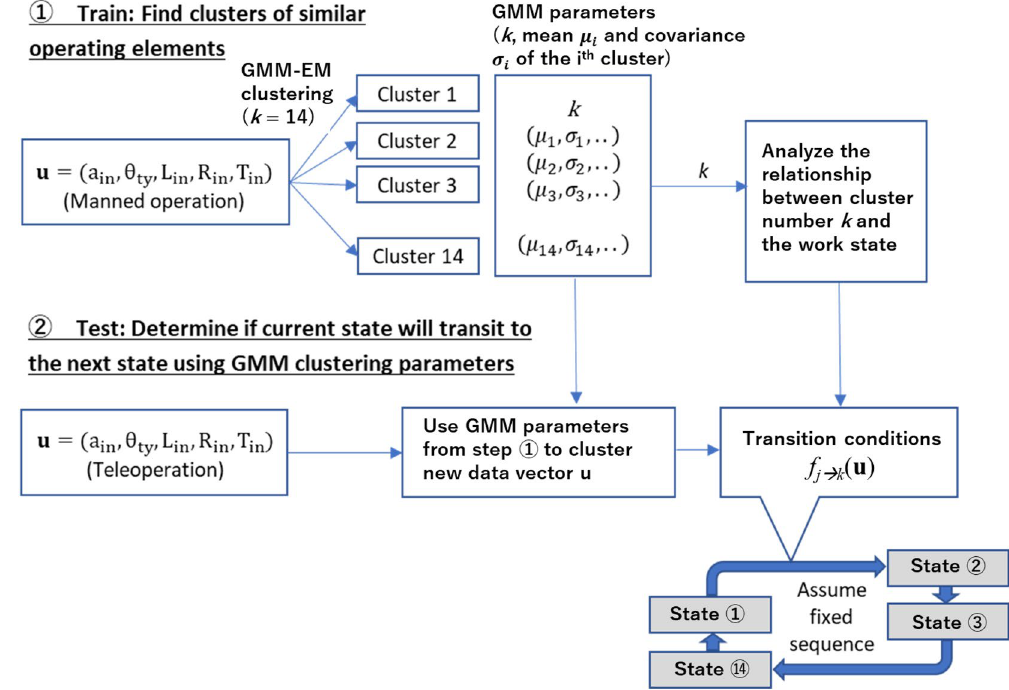
Figure 7. Work state estimation approach consists of training and testing of the GMM model, and using the parameters as transition